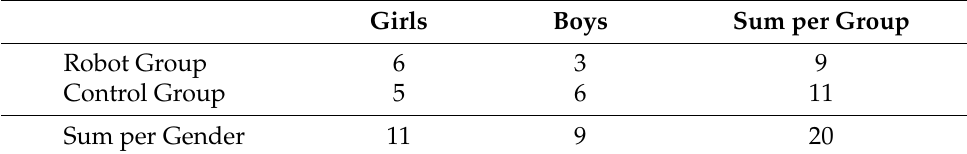
Table 2. Distribution of gender between trial